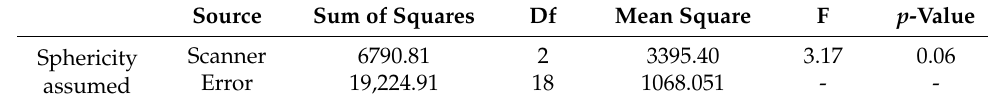
Table 1. One-way repeated measures ANOVA.